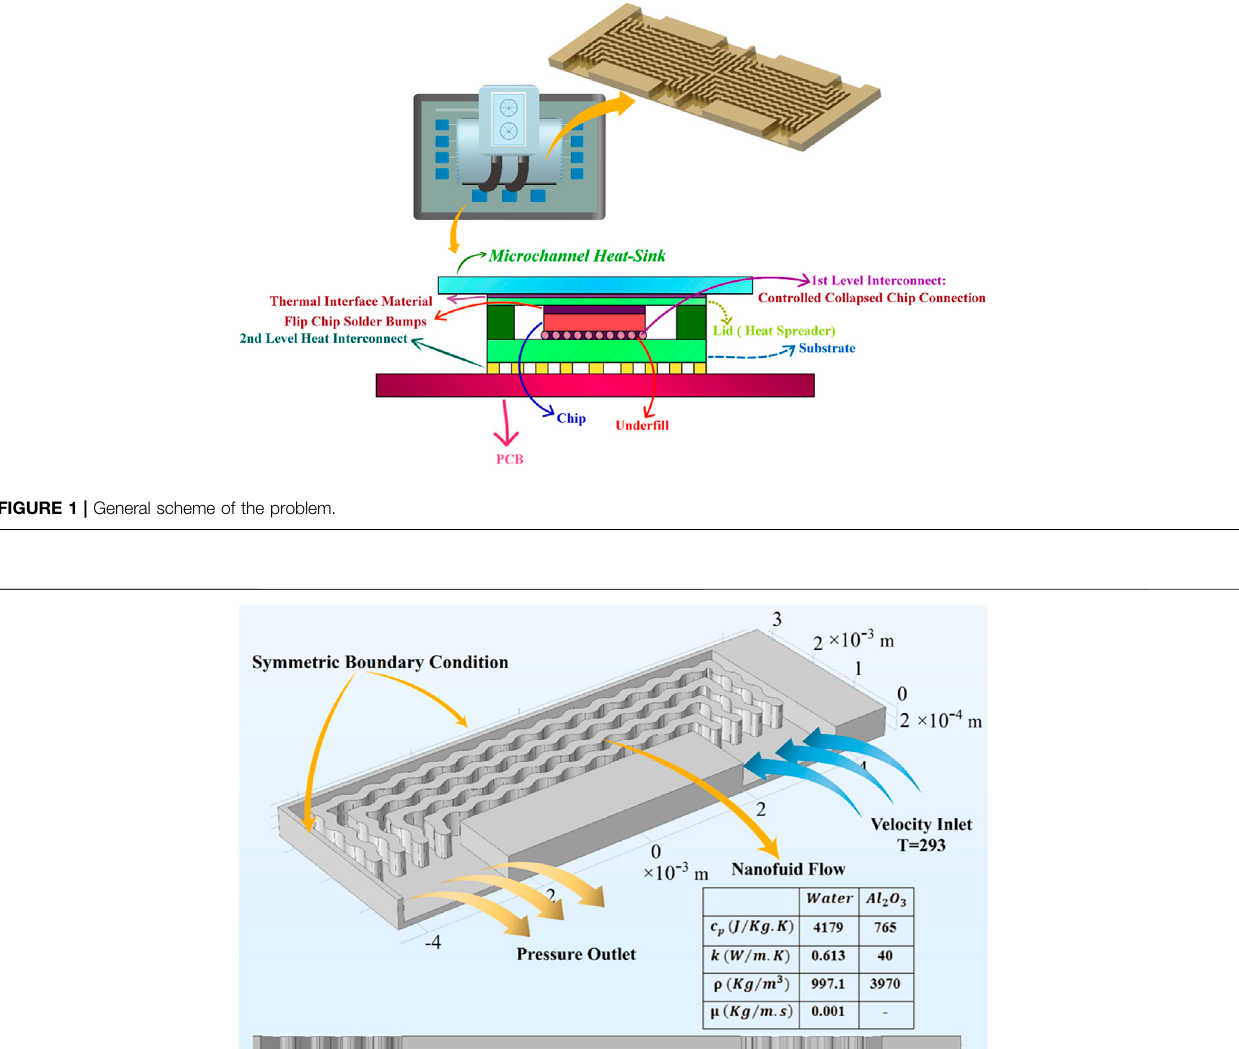
Frontiers in Energy Research |